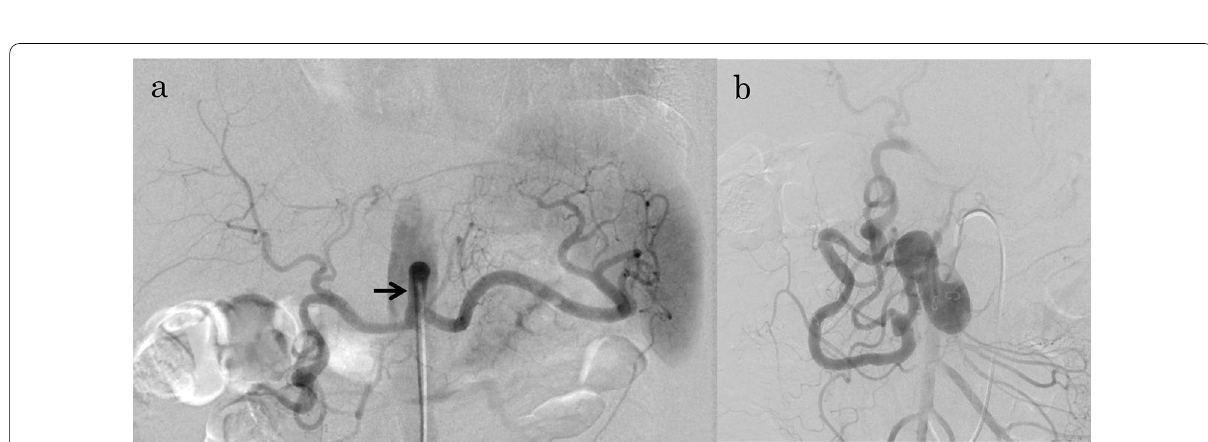
Fig. 3 Images after bypass surgery from Case 1. a , b Angiogram via bypass and superior mesenteric artery performed 6 days after bypass surgery showing excellent patency of the bypass (black arrow) and antegrade flow of the hepatic and splenic arteries and decreased retrograde flow of the PDA via the superior mesenteric